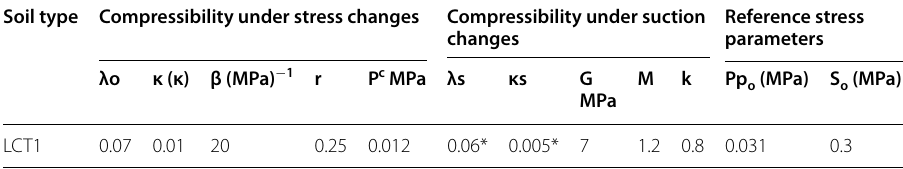
* This value was not provided in the reference. Therefore, reasonable values were used in this research